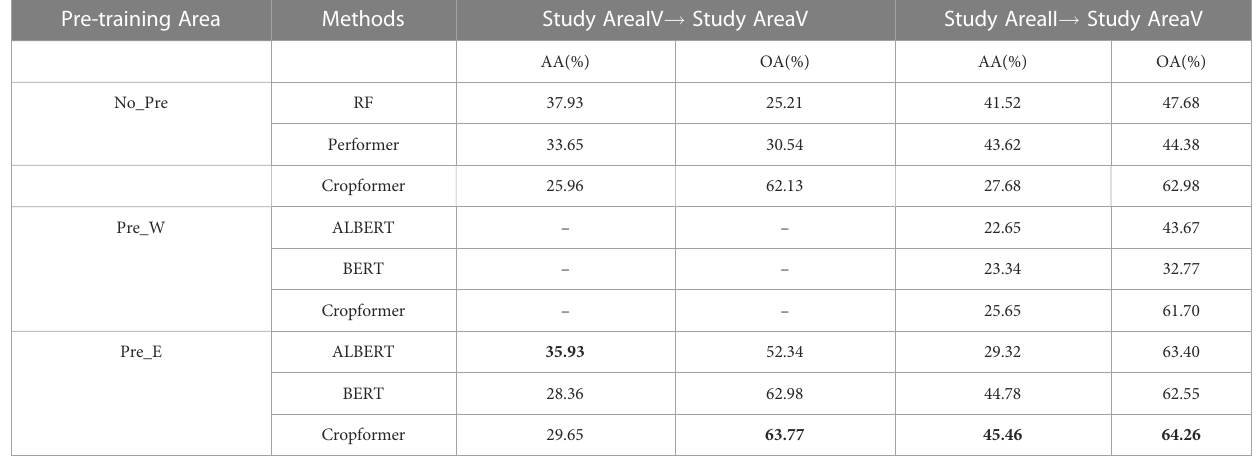
TABLE 4 Comparing the results of different transfer strategies. Pre-training Area